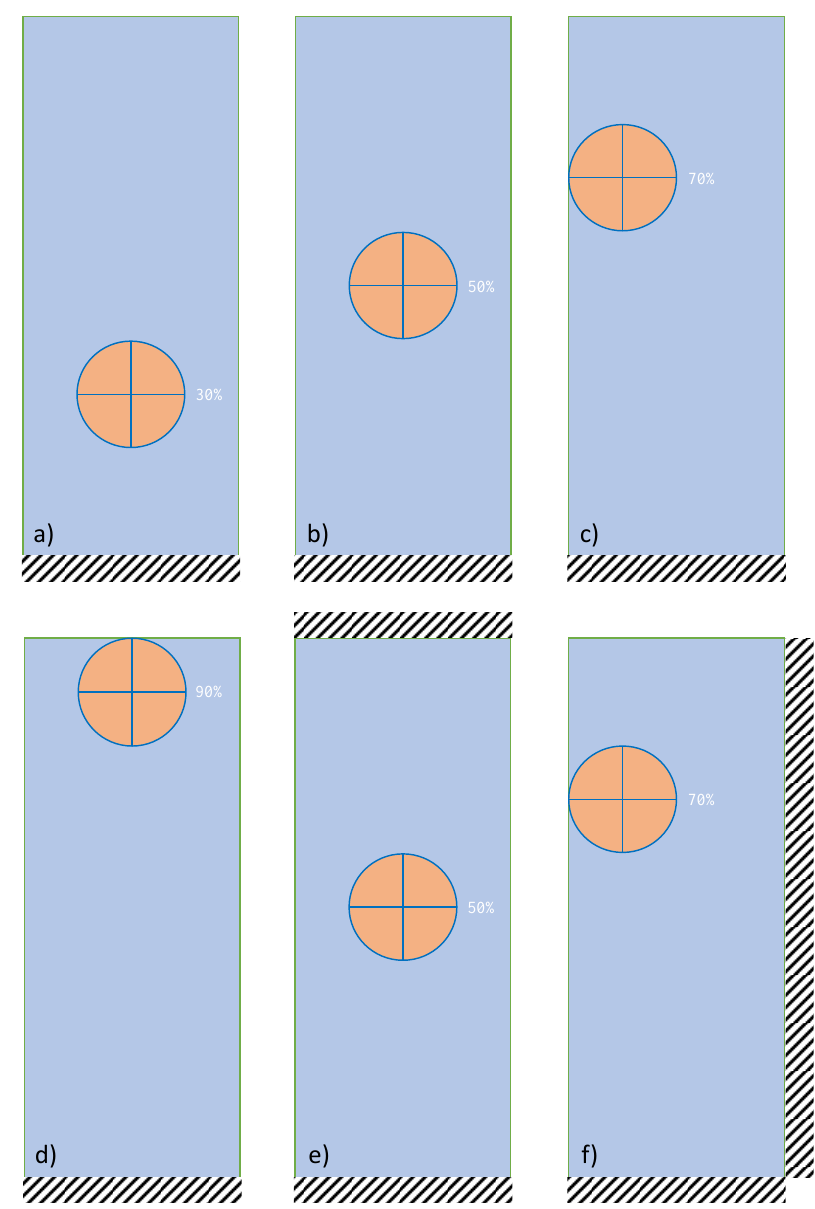
Figure 3. The six considered simulation cases with different impact locations and boundary condi- tions. ( a ) 30%, root clamped; ( b ) 50%, root clamped; ( c ) 70%, root clamped; ( d ) 90%, root clamped; ( e ) 50%, root & tip clamped; ( f ) 70%, root & side